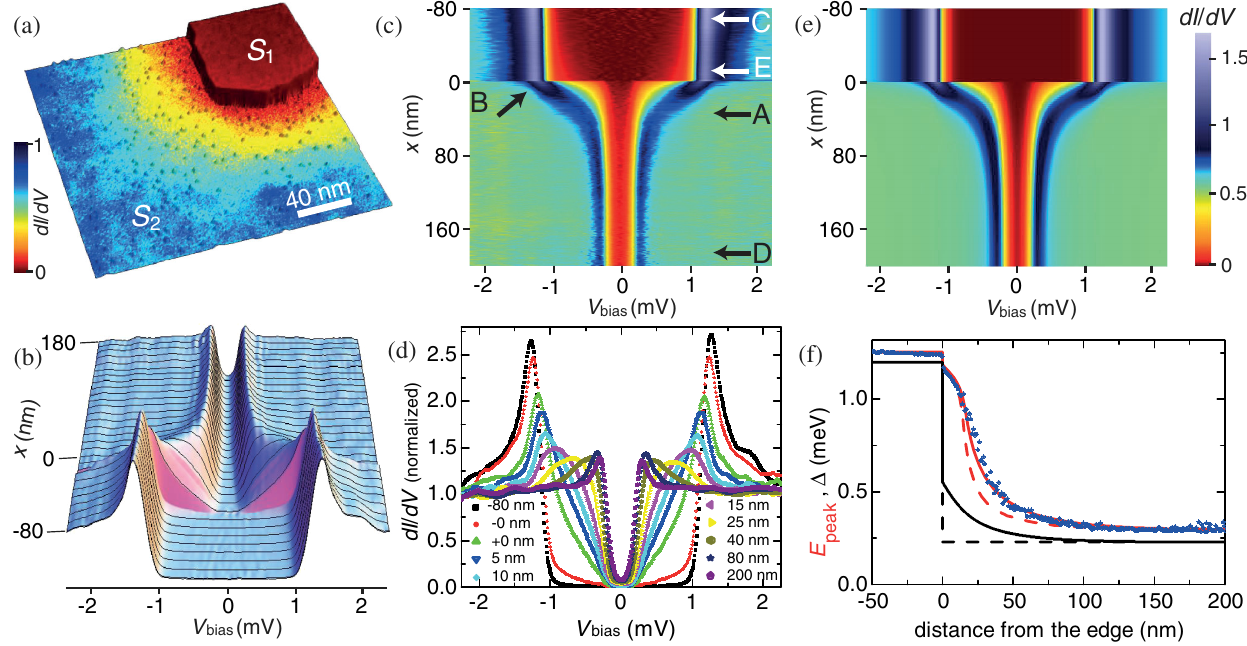
FIG. 2. S 1 - S 2 proximity effect at 0.3 K. (a) Topographic STM image of the sample showing the Pb nanoisland S 1 connected to